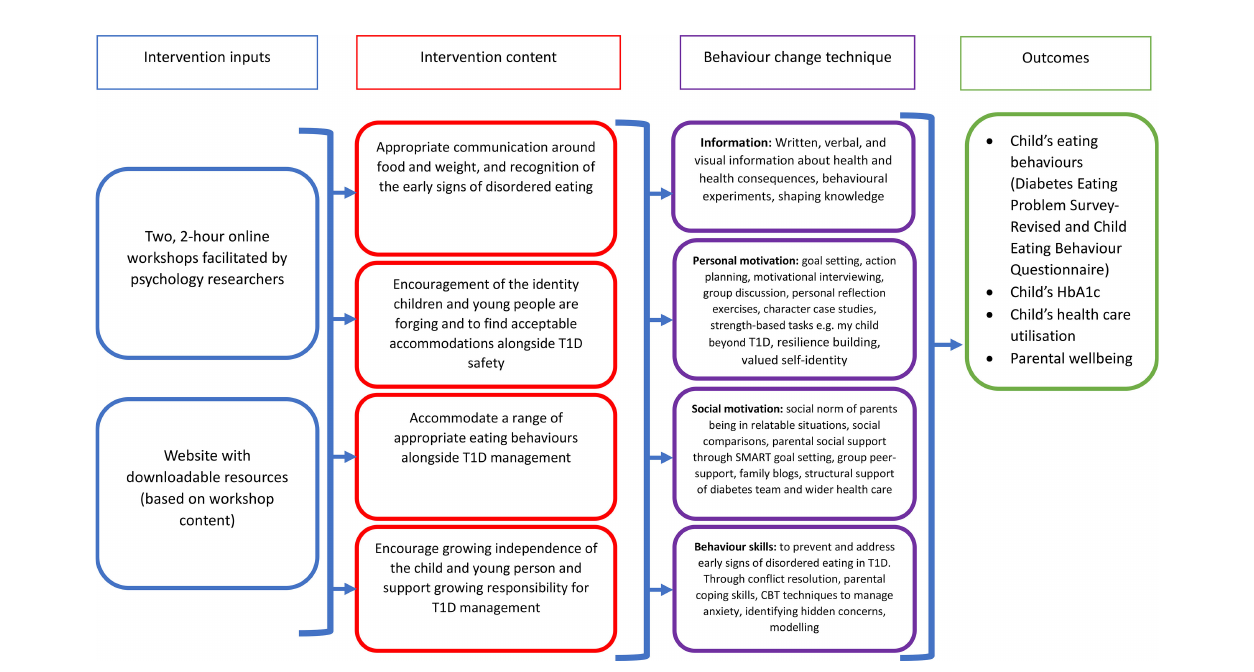
FIGURE 1 | Logic model detailing intervention components and impact pathways. Intervention activities have been mapped onto the Information-Motivation- Behavioural Skills